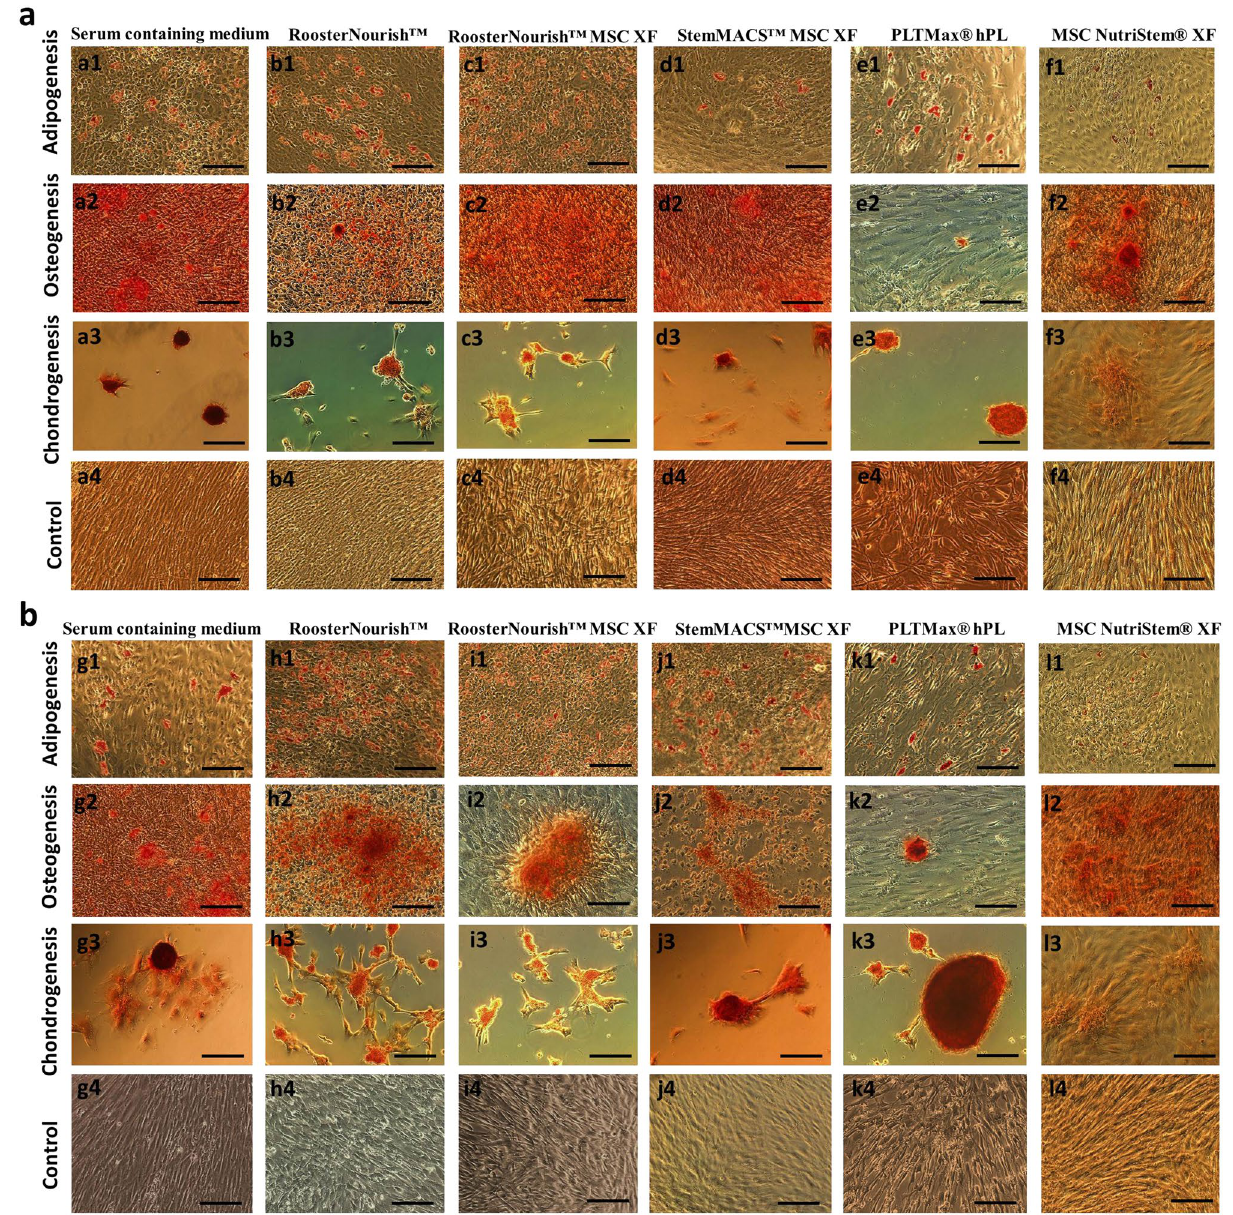
Figure 6. Differentiation potential of BM-MSCs cultured in vitro in low serum/SFM/XFM and control medium during freeze thaw analysis. BM-MSCs cultured at seeding density of 1000 cells/cm 2 and 5000 cells/cm 2 was cryopreserved. Freeze thaw analysis was carried out wherein the cells were thawed, revived and seeded to test their ability for trilineage differentiation. ( a ) BM-MSCs grown in SFM/XFM (1000 cells/cm 2 ) consistently differentiated into adipogenic ( a1-f1 ), osteogenic ( a2-f2 ) and chondrogenic ( a3-f3 ) lineages, non-induced controls ( a4-f4 ). b) BM-MSCs grown in SFM/XFM (5000 cells/cm 2 ) SFM differentiated into adipogenic ( h1- l1 ), osteogenic ( h2-l2 ) and chondrogenic ( h3-l3 ) lineages, non-induced controls ( h4-l4 ) except for BM-MSCs cultured in MSC NutriStem XF. Adipogenic differentiation was detected by oil droplet formation, (oil red O staining). Osteogenic differentiation indicated by calcium accumulation (alizarin red staining). Chondrogenic differentiation detected by Safranin O staining of glycosaminoglycan of cartilage. The images were captured at 10X magnification with scale bar of ∼ 100